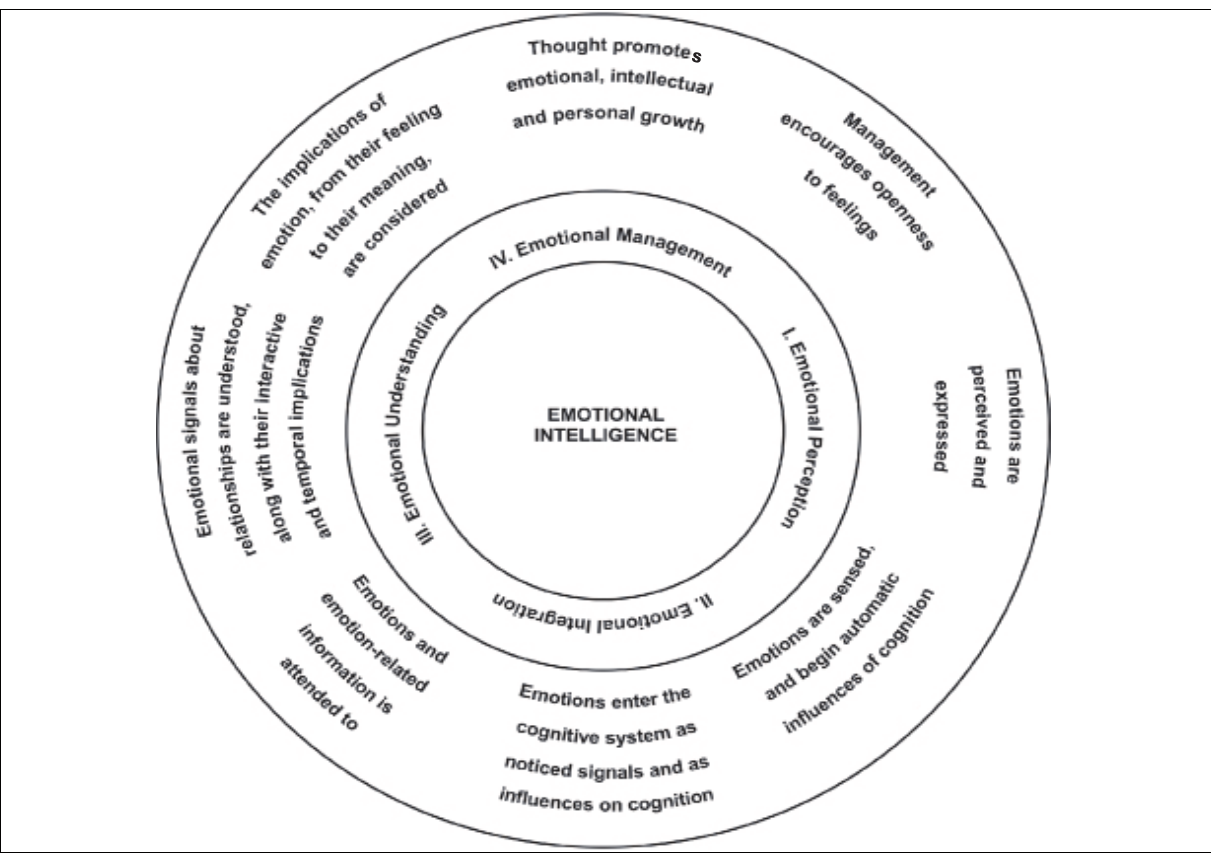
FIGURE 2 Model of emotional intelligence (Salovey & Mayer,